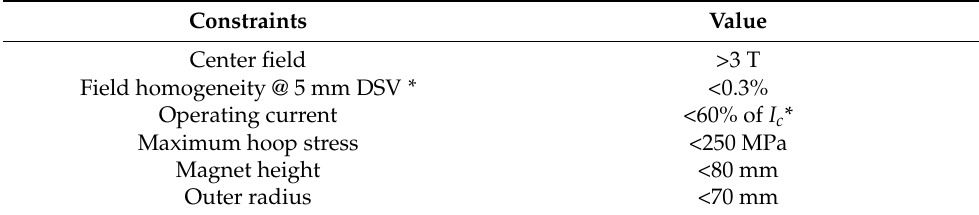
Figure 3. Structure and design variables of the 3 T REBCO magnet. Table 1. Design Constraints of the 3 T REBCO EMPS